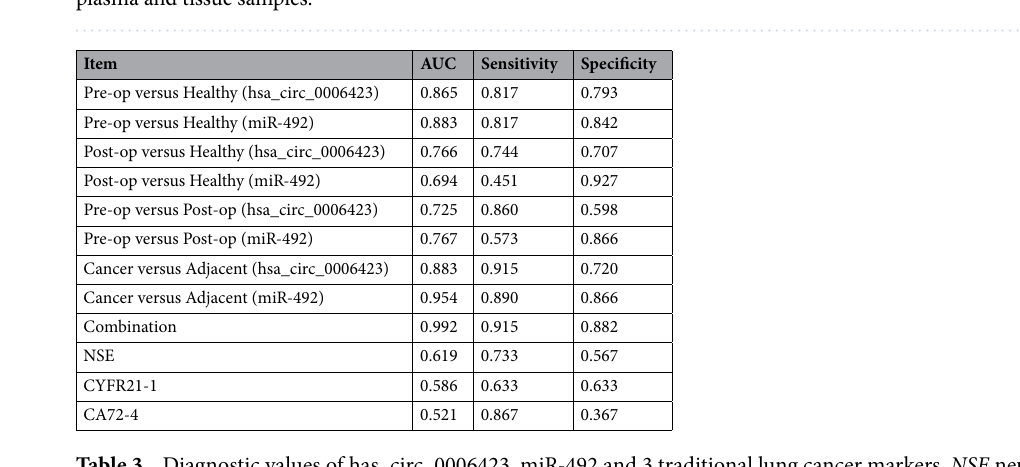
Table 3. Diagnostic values of has_circ_0006423, miR-492 and 3 traditional lung cancer markers. NSE neuron- specific enolase, CYFR21-1 cytokeratin-19-fragment, CA72-4 cancer antigen 72-4.